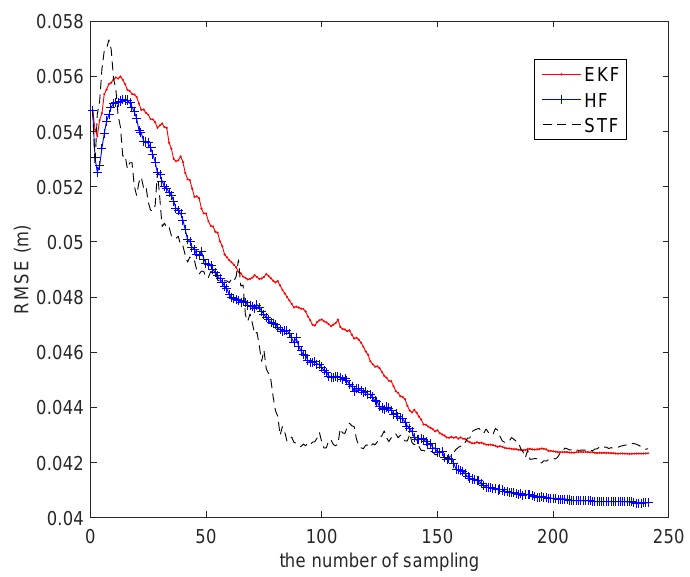
Figure 10. The RMSE of EKF, the H